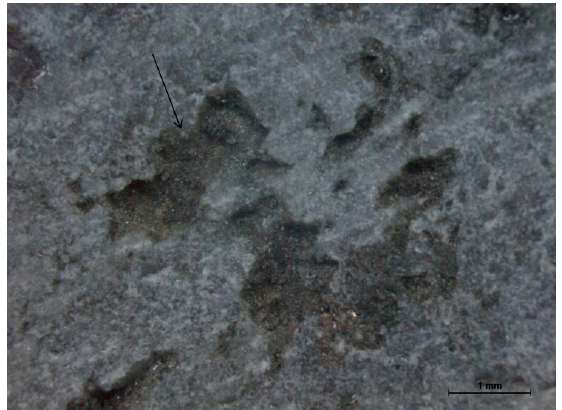
Figure 3. Stereo ‐ zoom image that displays the effect of minerals dissolution (arrow) on the surface of a gabbro ‐ diorite specimen after 64 days within brine.